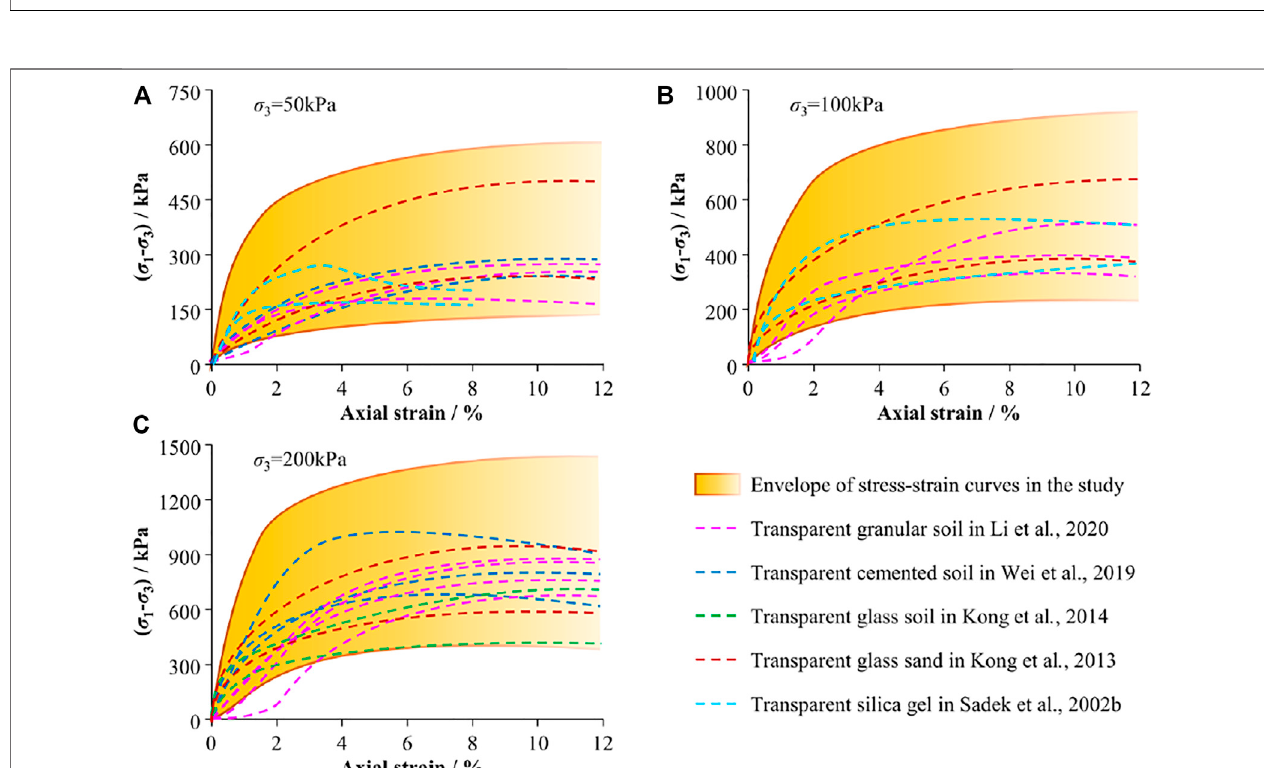
FIGURE 17 | Envelopes of stress – strain curves of the specimens in Table 1 at con fi ning pressures of 50 (A) , 100 (B) and 200 kPa (C) .